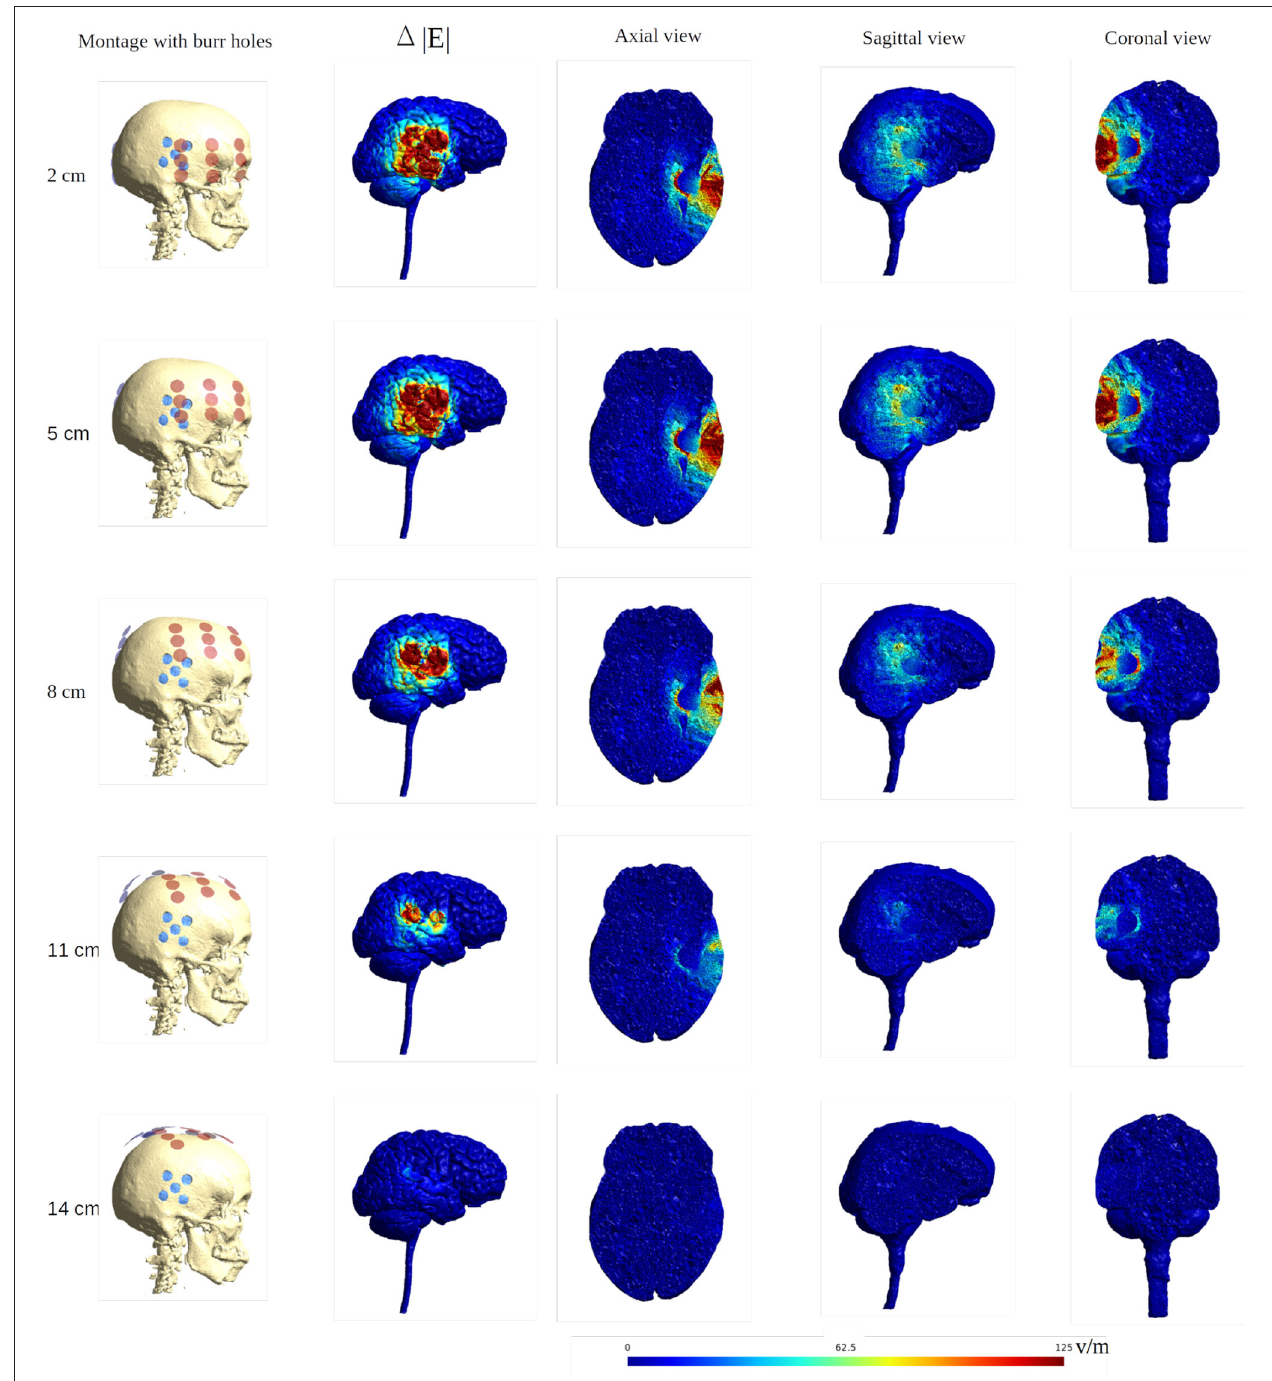
FIGURE 13 | Heat map of the electric field intensity enhancement of the SR surgery, with the moving of the arrays toward the central craniocaudal axis. The positions of the electrode arrays were also shown in Figures 3C , 11 in different views. The red and blue dots in the first column represent the placements of the electrodes and the burr holes. The second column gives the enhancement on the gray matter surface, and the last three columns show all views of the E field enhancement.